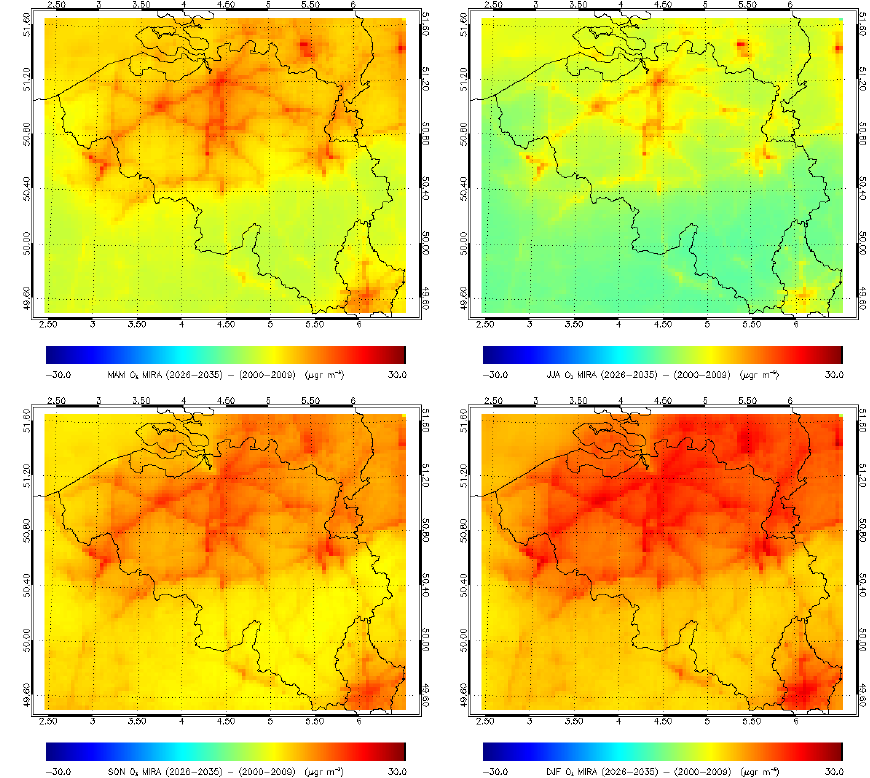
Figure 6. Mean difference maps between the near future (2026–2035) and the present day (2000–2009) for the MIRA scenario per